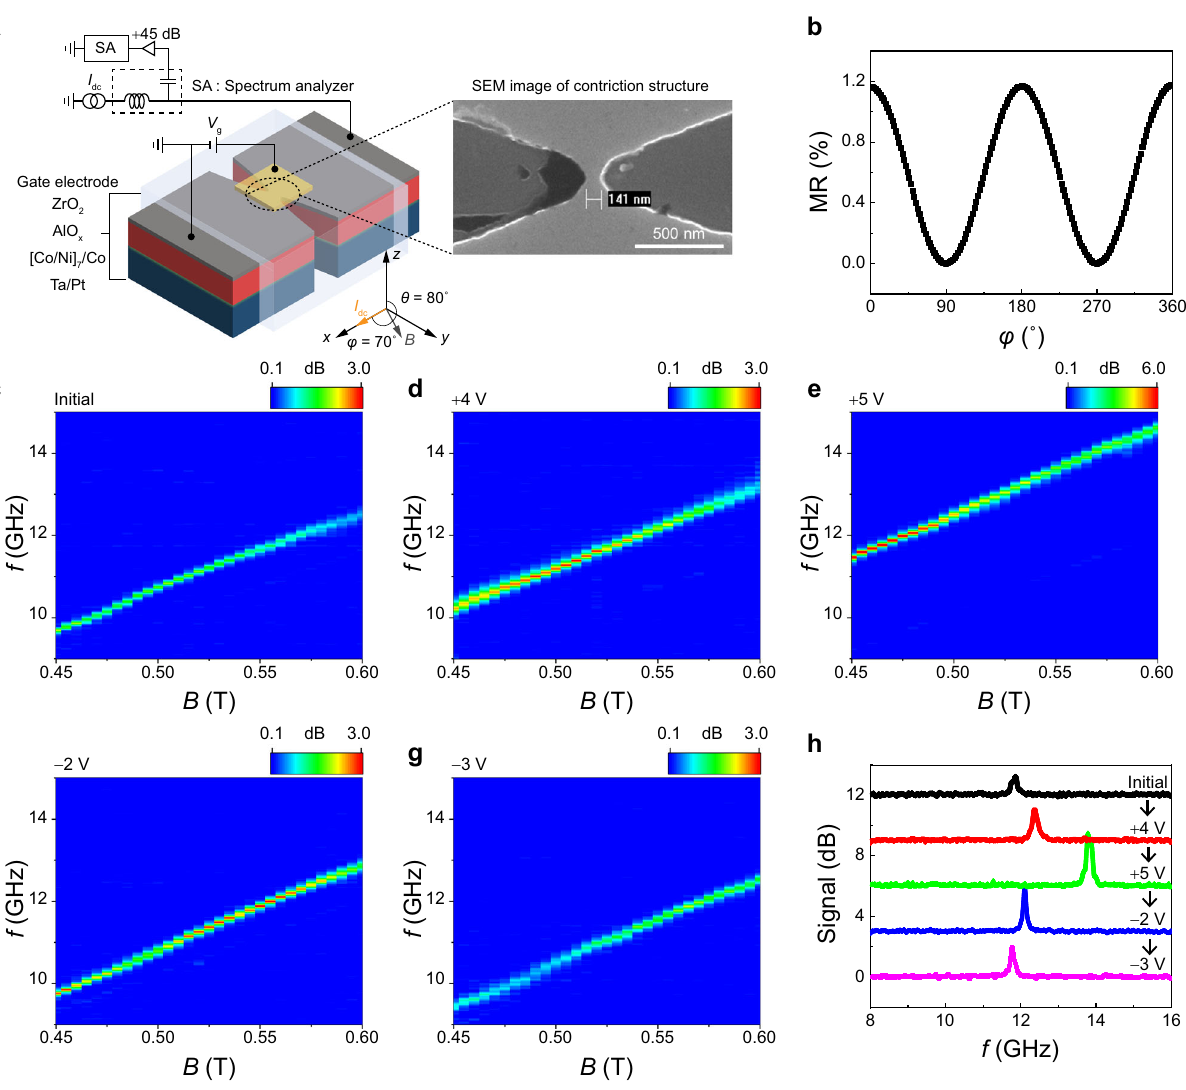
Fig. 3 Magnetic fi eld-dependent voltage-driven frequency tuning of SHNO. a Schematic illustration of the experimental set-up. The inset is a scanning electron microscope image of a SHNO device. b Angle-dependent magnetoresistance (MR) of the Co/Ni sample. c – g Power spectral densities (PSDs) as a function of magnetic fi eld for sequentially applied gate voltages, V g = 0 V (initial state) ( c ), V g = + 4 V ( d ), V g = + 5 V ( e ), V g = − 2 V ( f ), and V g = − 3 V ( g ). I = 2.9 mA. h Auto-oscillation spectra for B = 0.56T with different gate voltages, extracted from Fig. 3c – dc